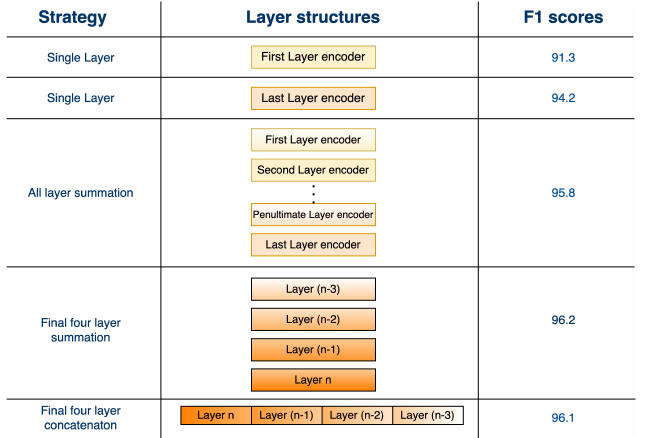
Figure 5. This Figure depicts different strategies for obtaining better embedding for our problem. Each layer in the figure corresponds to the layer of the BERT-Base, which consists of 12 layers of transformer encoders.